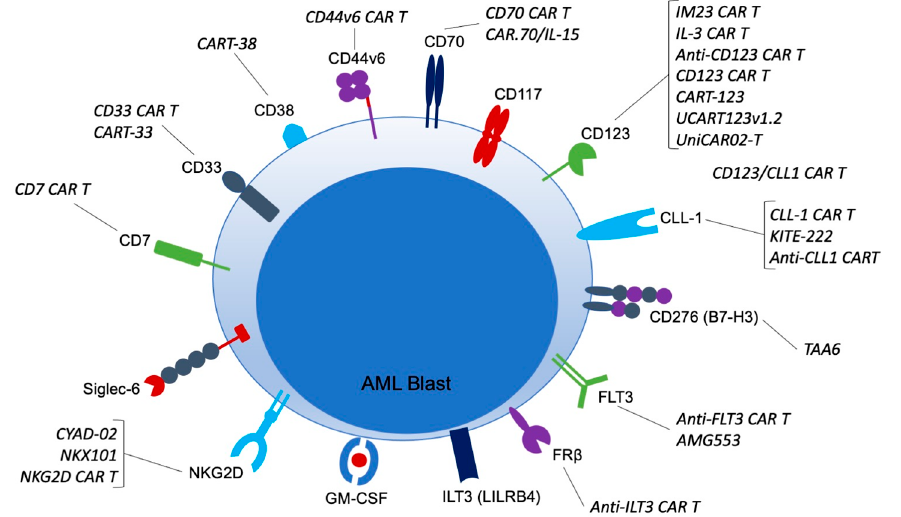
Figure 1. CAR targets in AML and CAR therapies currently in clinical trials. CAR = chimeric antigen receptor; AML = acute myeloid leukemia; CD = cluster of differentiation; CLL-1 = C-type lectin-like molecule-1; FLT3 = FMS related receptor tyrosine kinase 3; FRb = folate receptor b; HSC = hematopoietic stem cell; GM-CSF = granulocyte-macrophage colony-stimulated factor; ILT3 = Ig-like transcript 3; LSC = leukemic stem cell; NKG2D = natural killer group 2 member D; Siglec-6 = sialic acid binding Ig-like lectin 6